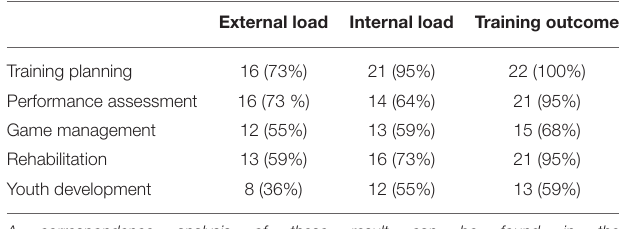
TABLE 1 | Number of clubs invited per federation * and corresponding response number and rate. Invited